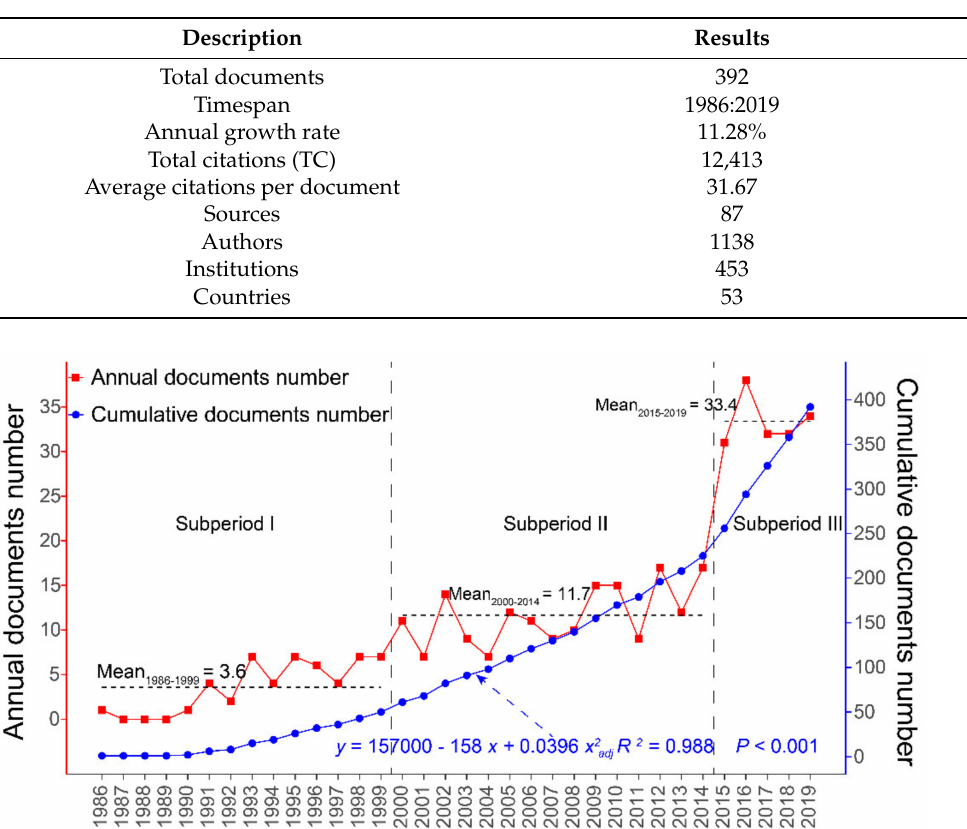
Table 2. Principal information about the 1986–2019 IHS collection.